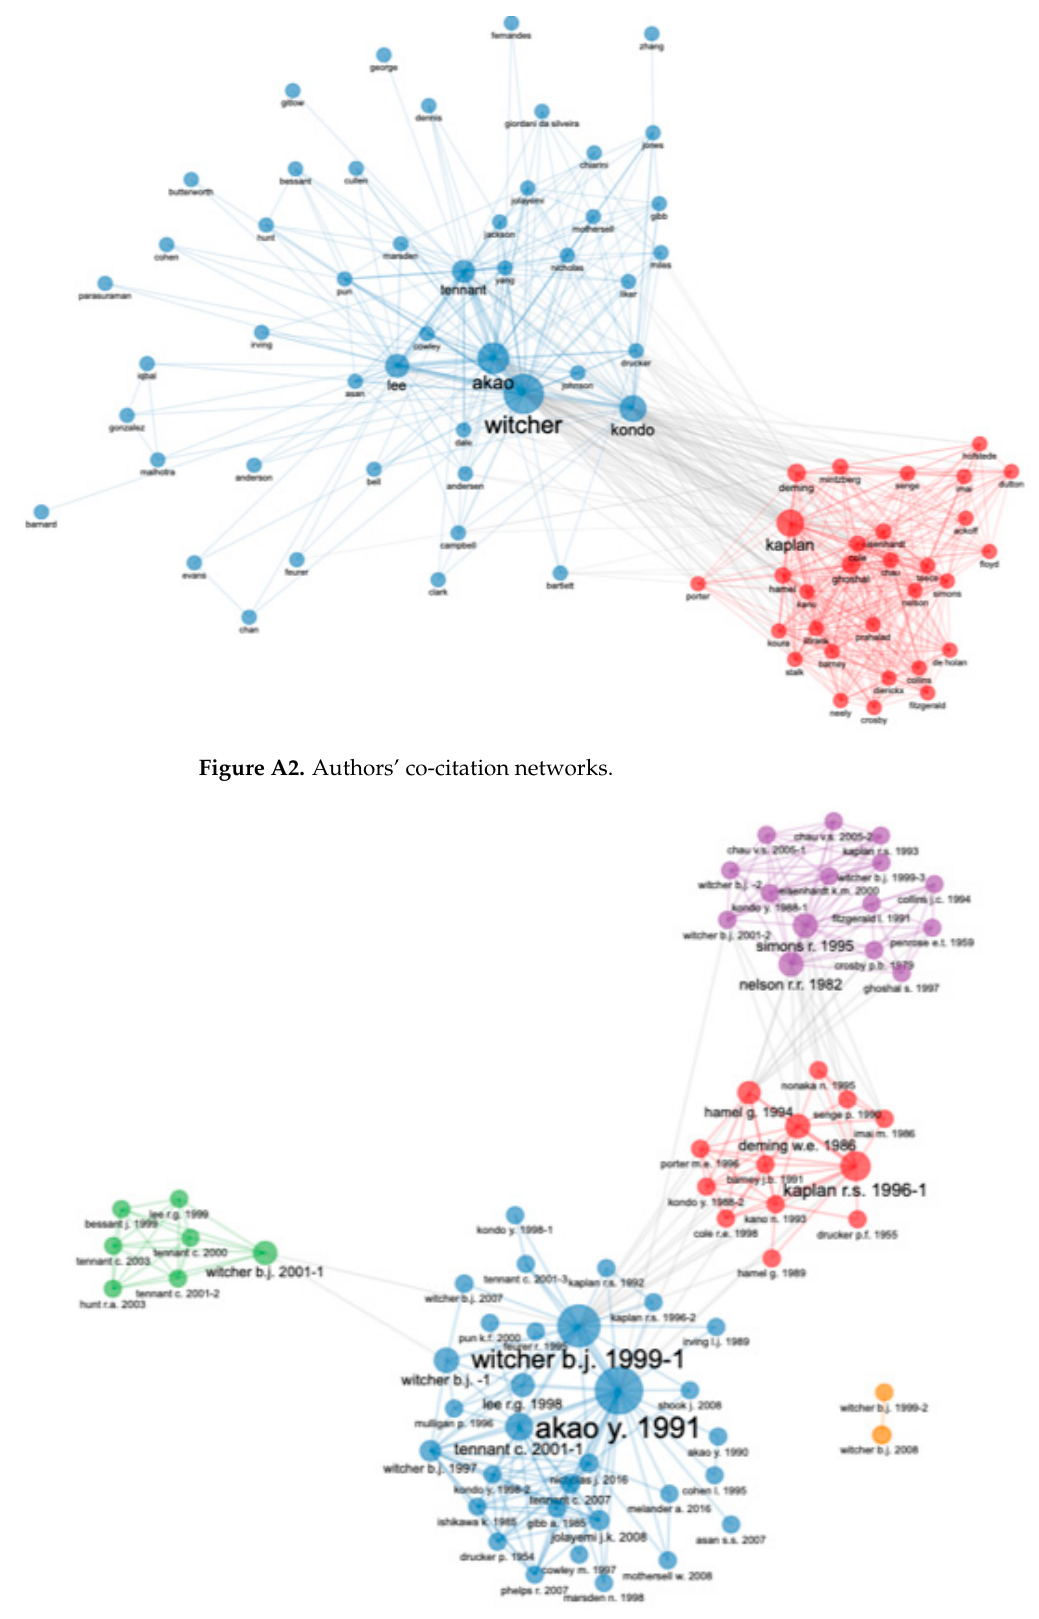
Figure A1. Authors’ collaborative network.